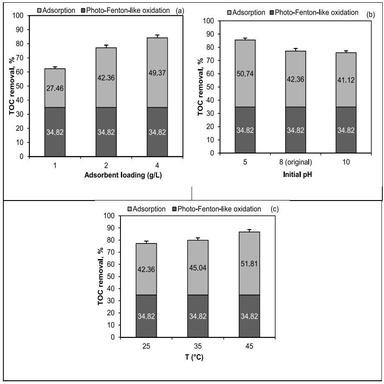
Effect of parameters on TOC removal by adsorption for photo-Fenton-like oxidation effluent (Conditions: tadsorption = 24 h, 0 = 51 mg/L) (a) adsorbent loading (Conditions: pH0 = 8, T = 25 ◦C) (b) initial pH (Conditions: = 2 g/L, T = 25 ◦C) (c) temperature (Conditions: = 2 g/L, pH0 = 8).